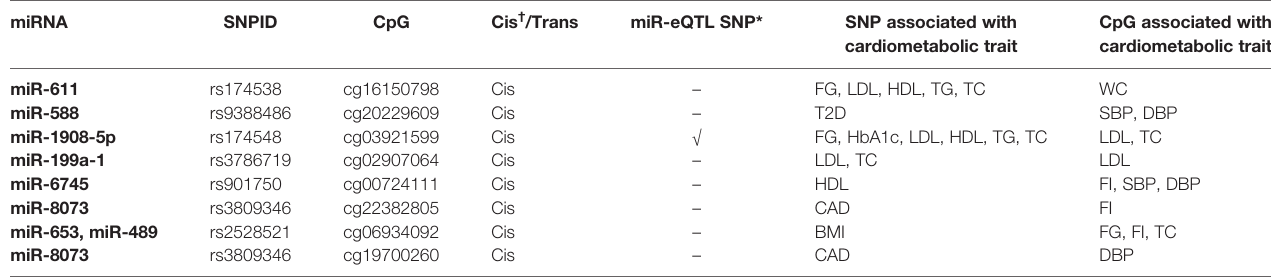
TABLE 3 | Identi fi ed me-QTLs with cardiometabolic-associated CpGs.